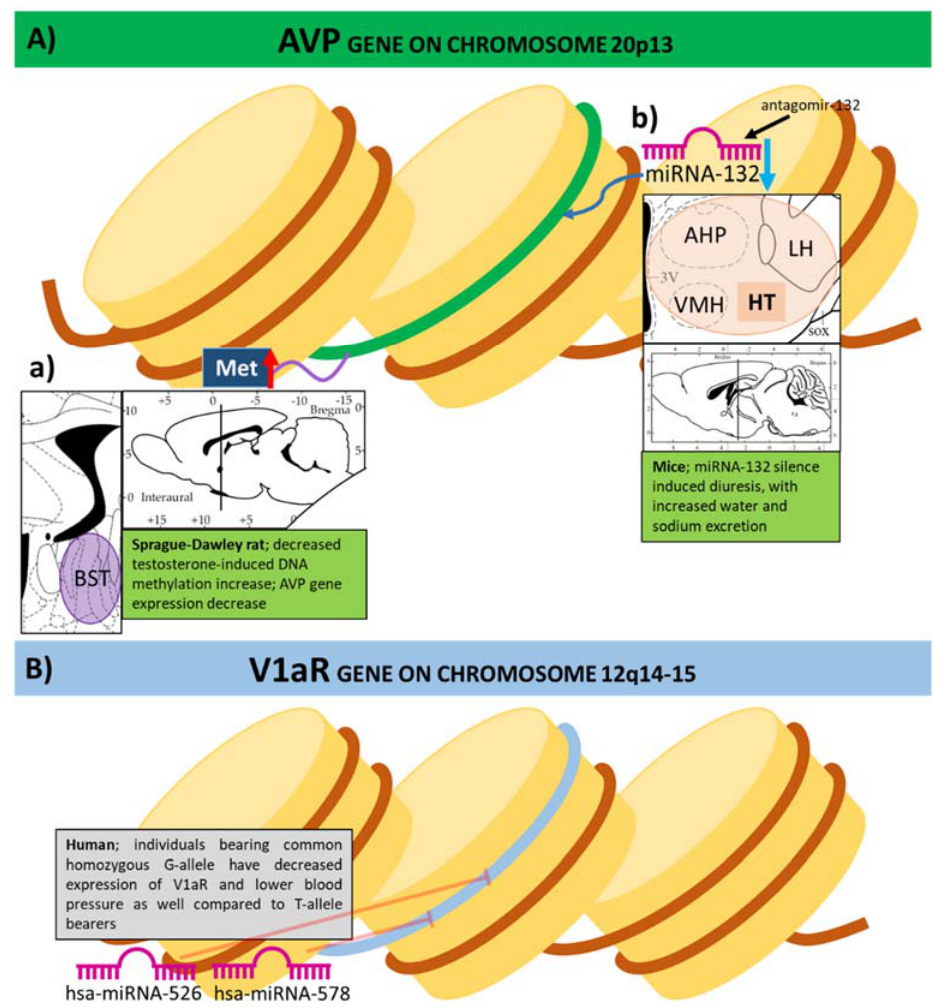
Figure 4. Decreased vasopressin (AVP, A )- or AVP receptor ( B ) gene expression changes linked to epigenetic effects in the literature. ( A ) AVP gene ( a ) Hypermethylation on AVP gene in bed nuclei of stria terminalis (BST) decreased AVP expression by reduced testosterone levels in Sprague-Dawley rats. ( b ) Antagomir-132-induced microRNA (miRNA)-132 silencing in the mouse hypothalamus (HT) resulted in diuresis with increased water and sodium excretion; AHP: anterior hypothalamus posterior region; LH: lateral hypothalamus; VMH: ventromedial hypothalamus. ( B ) A study about human genome-wide single-nucleotide polymorphisms found an association between the polymorphism of miRNA binding site of the V1aR gene and blood pressure. Two variants were identified: a common G-allele and a rare T-allele (see Figure 3(Ba)). In vitro, Homo sapiens (hsa)-miRNA-526 and hsa-miRNA-578 reduced V1aR gene expression in case of the common G-allele. GT: guanine-thymine allele variant in V1a receptor gene.